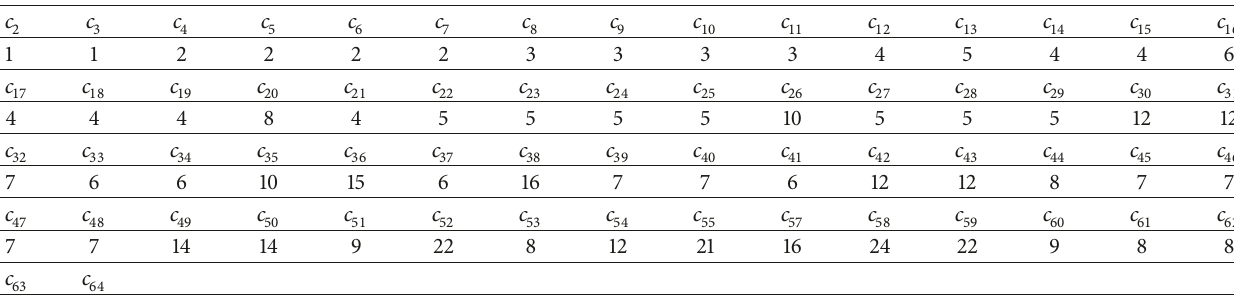
Table 1: Extraction Function Coefficient 𝑐 𝐵 of APPM.